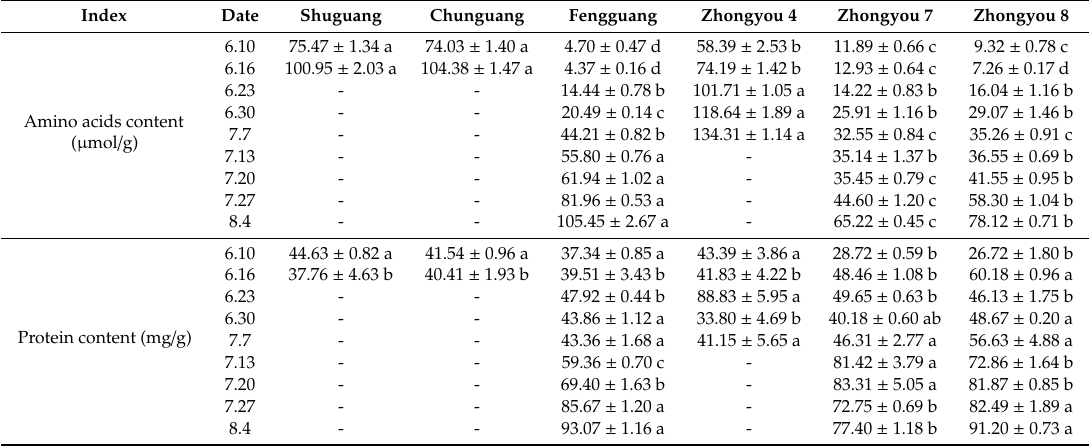
Table 6. The amino acids and protein content of nectarine